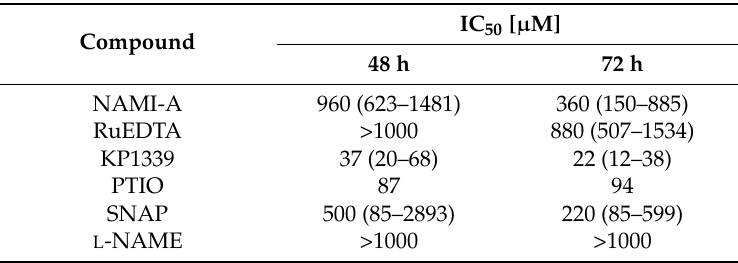
Table 1. IC 50 values of imidazolium trans -imidazoledimethylsulfoxidetetrachloro-ruthenate (NAMI-A), potassiumchlorido(ethylendiamminotetraacetate)rutenate(III) (RuEDTA), sodium (bis-indazole) tetrachloro-ruthenate(III), Na[ trans -RuCl 4 Ind 2 ] (KP1339),